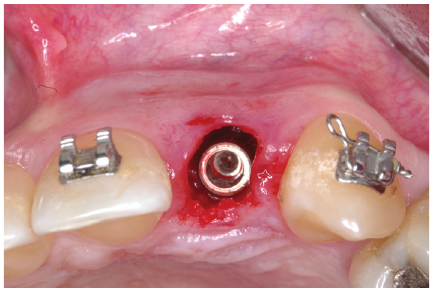
Figure 4: Peri-implant defect.